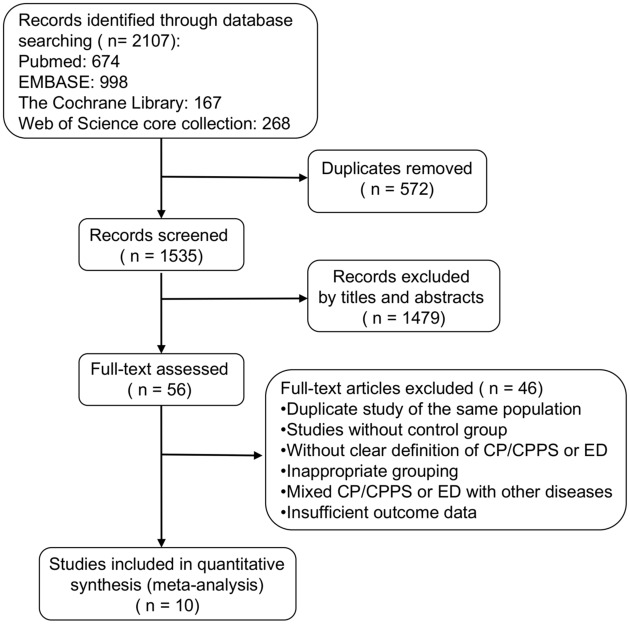
Flow diagram of literature search and study selection.CP/CPPS = chronic prostatitis/chronic pelvic pain syndrome, ED = erectile dysfunction.